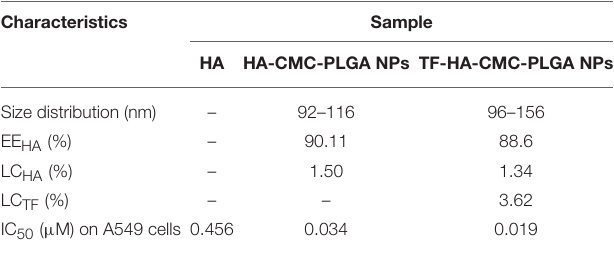
TABLE 1 | HA, HA-CMC-PLGA NPs, and TF-HA-CMC-PLGA NPs characterization